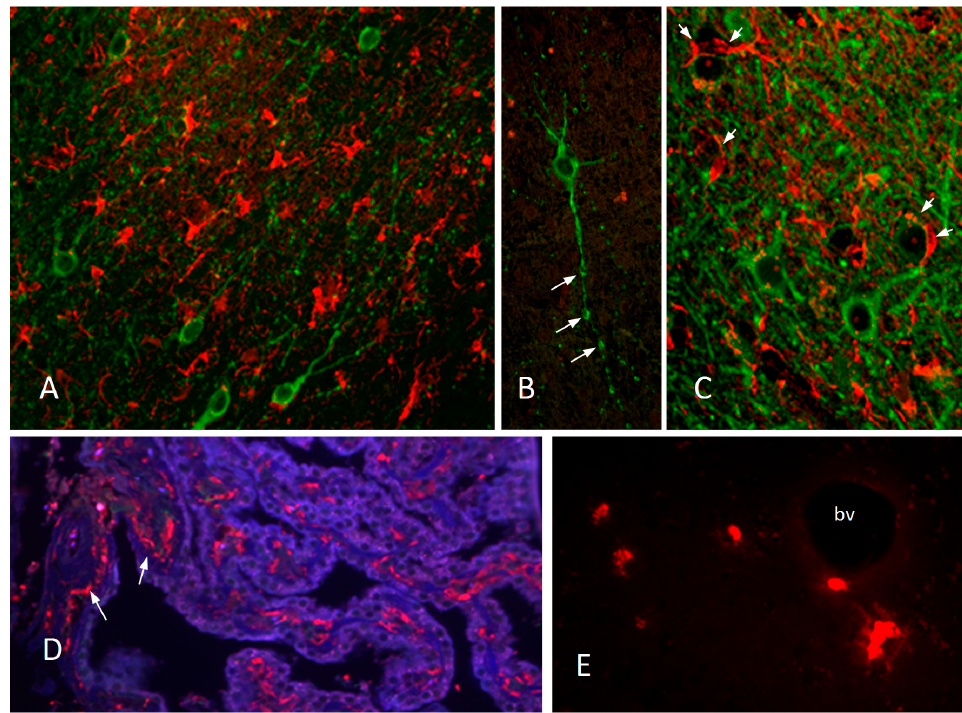
Figure 3. The CNS response to FIV infection. ( A ) Activated microglia stained with an antibody to Iba1 (red) are abundant in the subcortical white matter at the interface between the frontal cortex and basal ganglia. Neurons are stained for MAP-2 (green). ( B ) An example of a single MAP-2+ neuron (green) at the cortical-basal ganglia interface with varicosities in the dendrites indicative of early damage. ( C ) Iba1+ microglia (red) are often seen wrapping neurons in the FIV infected brain but are rare in normal brain. ( D ) An increased number of Iba1+ macrophages (red) populate the choroid plexus in an FIV infected cat. The cuboidal epithelium is stained for cytokeratin (blue). ( E ) Small clusters and scattered macrophages stained for Mac387 (red), a marker of newly migrated macrophages, are seen surrounding blood vessels (bv) in the basal ganglia and cortex (not shown).